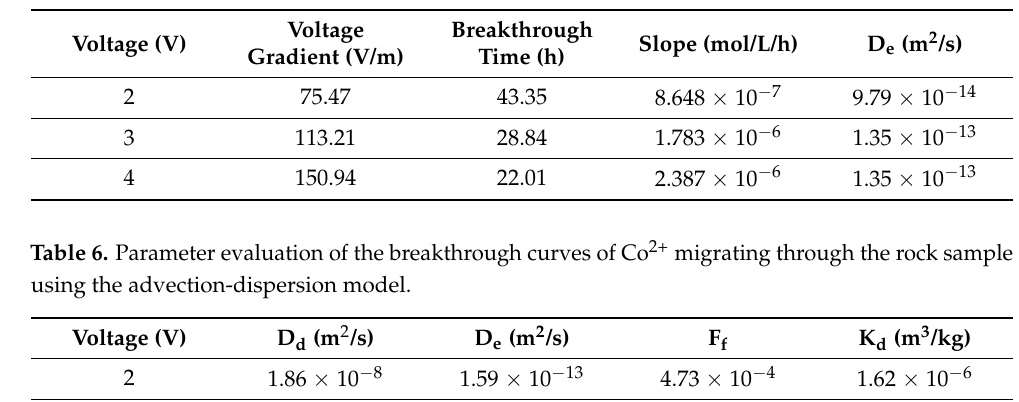
Table 5. Electromigration experimental results with ideal plug-flow modeling of Co 2+ migration through the rock sample.